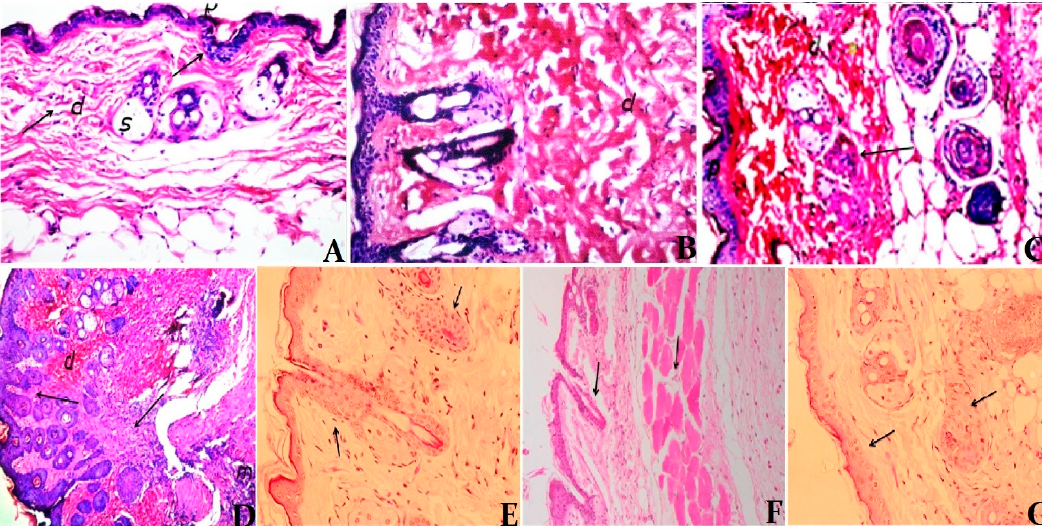
Figure 8. Hematoxylin and eosin-stained skin sections at four weeks post infection. ( A ) Control group, showing the normal histological structure of the epidermis, dermis, subcutaneous tissues and musculature layer (×200). ( B ) Untreated infected group, showing intact histological structure of the epidermis (P) and dermis (d), and no histopathological alteration in both epidermal and dermal layers (×400). ( C ) Untreated infected group, showing suppurative liquefactive necrosis with pus formation in deep subcutaneous tissue (×400). ( D ) Pentostam-treated group, showing acanthosis in dermal layer and infiltration of inflammatory cells in both the dermal layer (d) and subcutaneous musculature tissue (m) (×400). ( E ) Pomegranate juice-supplemented group, showing normal histological structure of epidermis and dermis and infiltration of few inflammatory cells in the dermal and subcutaneous tissue (×200). ( F ) Pomegranate juice-supplemented with antibiotic treated group showing normal histological structure of the epidermis and dermis layers (×400). ( G ) Pre-pomegranate juice-supplemented group, showing normal histological structure of the epidermis and dermis layers (×400).